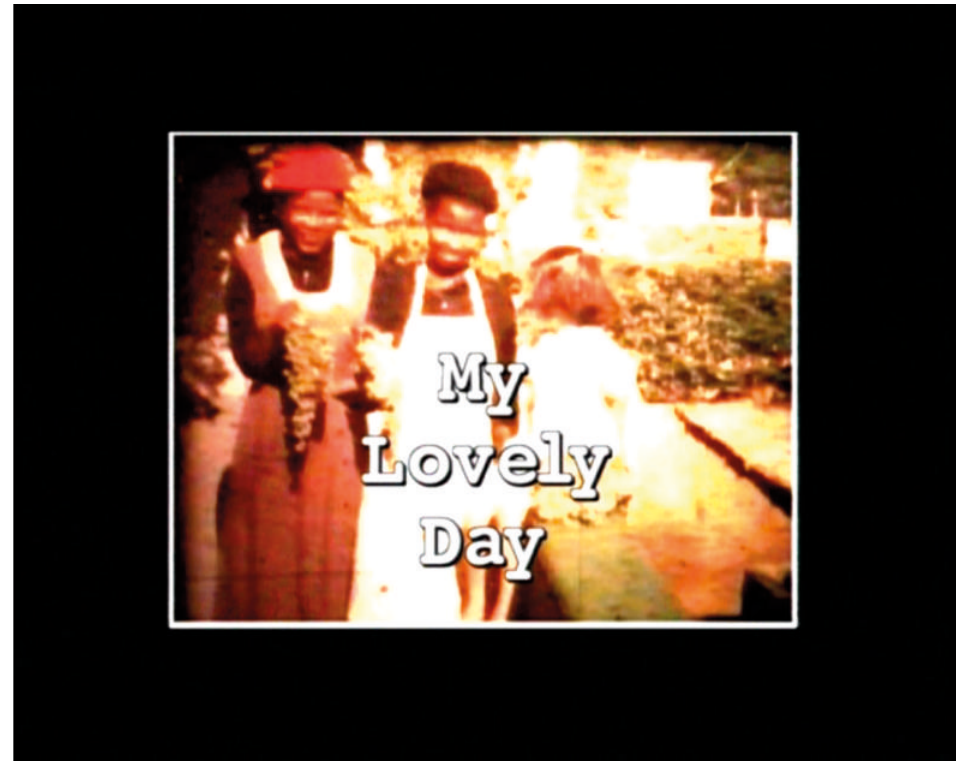
Figure 2 Penny Siopis, My Lovely Day (film still), 3rd ed., 1997. Video installation of mini cinema and 8mm film transferred to video, 21 minutes. Museum of Modern Art, Stockholm; South African National Gallery, Cape Town; the artist (photo: courtesy Penny Siopis and Stevenson Gallery, Cape